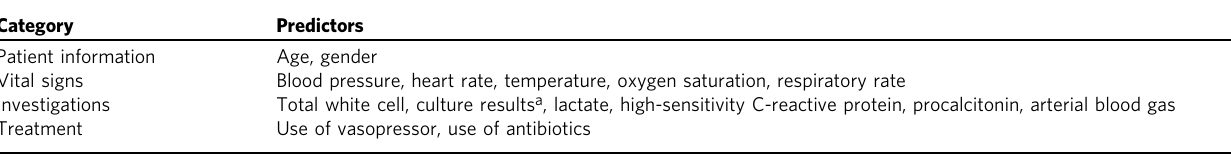
Table 1 List of structural variables used in the predictive